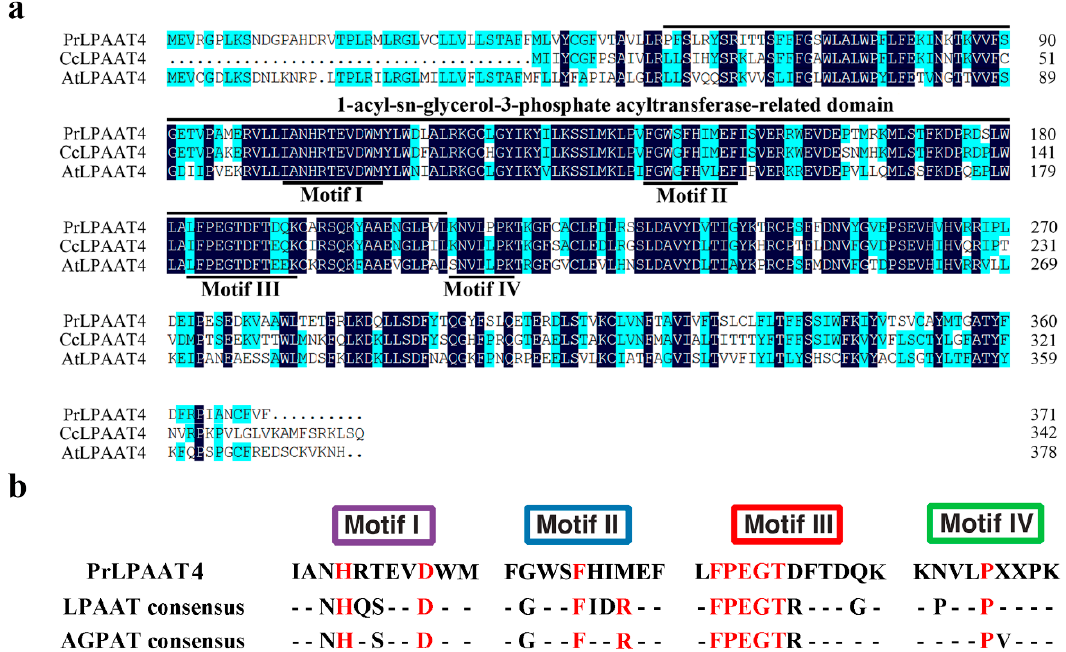
Figure 1. Sequence analysis of PrLPAAT4. ( a ) alignment of deduced PrLPAAT4 amino acid sequence with similar proteins from Citrus clementina CcLPAAT4 (XP_006423197) and Arabidopsis AtLPAAT4 (NP_565098). Identical amino acids are boxed in dark bule and similar amino acids are shaded in light blue . Solid lines indicate the conserved 1-acyl-sn-glycerol-3-phosphate acyltransferase-related domain. The conserved acyltransferase motifs (I–IV) are underlined; ( b ) acyltransferase motifs in PrLPAAT4, LPAATs, and AGPATs. The conserved amino acid residues are shown in red.